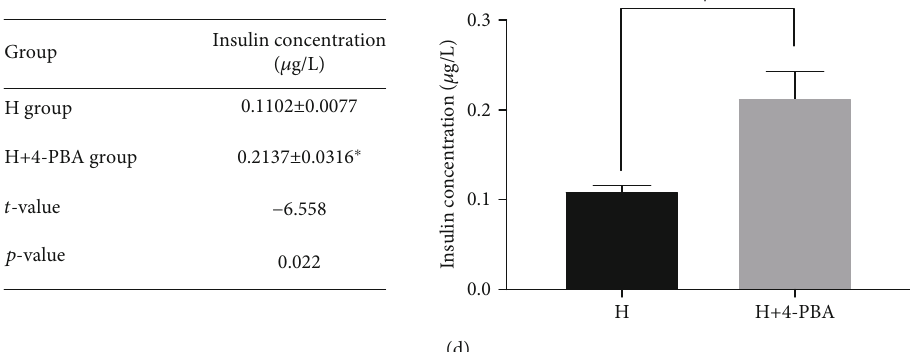
Figure 3: Expression of speci fi c proteins of ER and insulin in β -cells treated with di ff erent concentrations of T3. N group: normal- concentration T3 (5 pg/mL); H-group: high-concentration T3 (20pg/mL); H+4-PBA group: high-concentration T3 (20 pg/mL)+4-PBA (1 mmol/L). (a) Western blotting analysis showed that the expression of GRP78, PERK, IRE1, and ATF6 in the H group was signi fi cantly higher than that in the N group. (b) The expression of GRP78, PERK, IRE1, and ATF6 in the H+4-PBA group was signi fi cantly lower than that in the H group. (c) The expression of p-IRS-1 ser307 in the H+4-PBA was signi fi cantly lower than that in the H group, whereas Akt expression was higher than that in the H group. (d) ELISA showed that the concentration of insulin in the supernatant of the H group was signi fi cantly lower than that of the H+4-PBA group ( n = 3 , ∗ p < 0 : 05 , ∗∗ p < 0 : 01 ). ELISA: enzyme-linked immunosorbent assay.